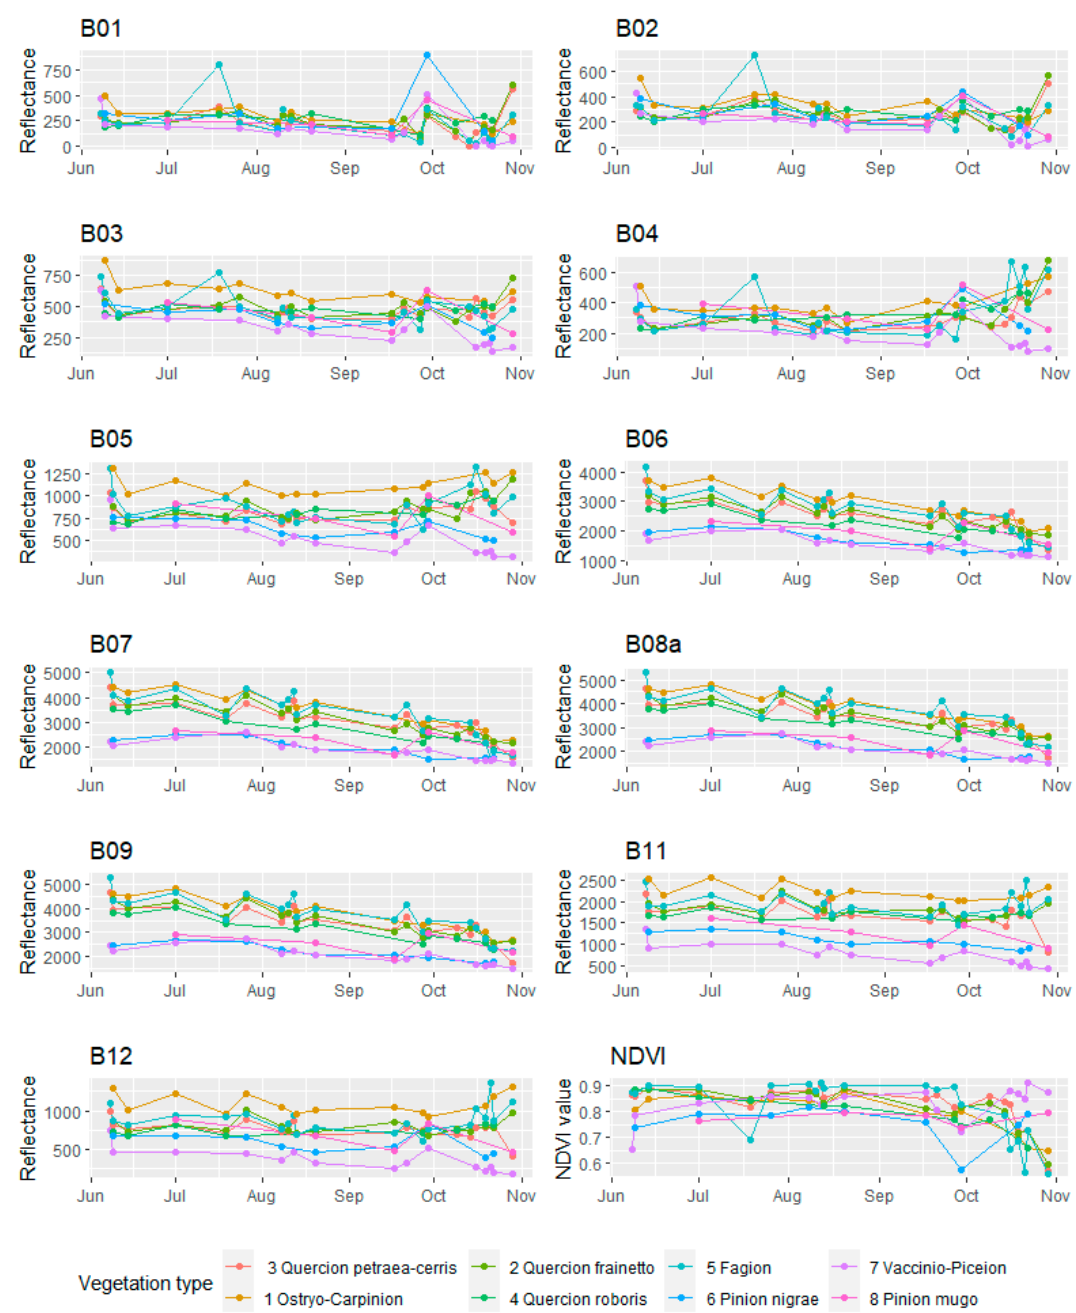
Figure 7. Temporal phenological patterns for the used Sentinel-2 spectral bands and NDVI values.